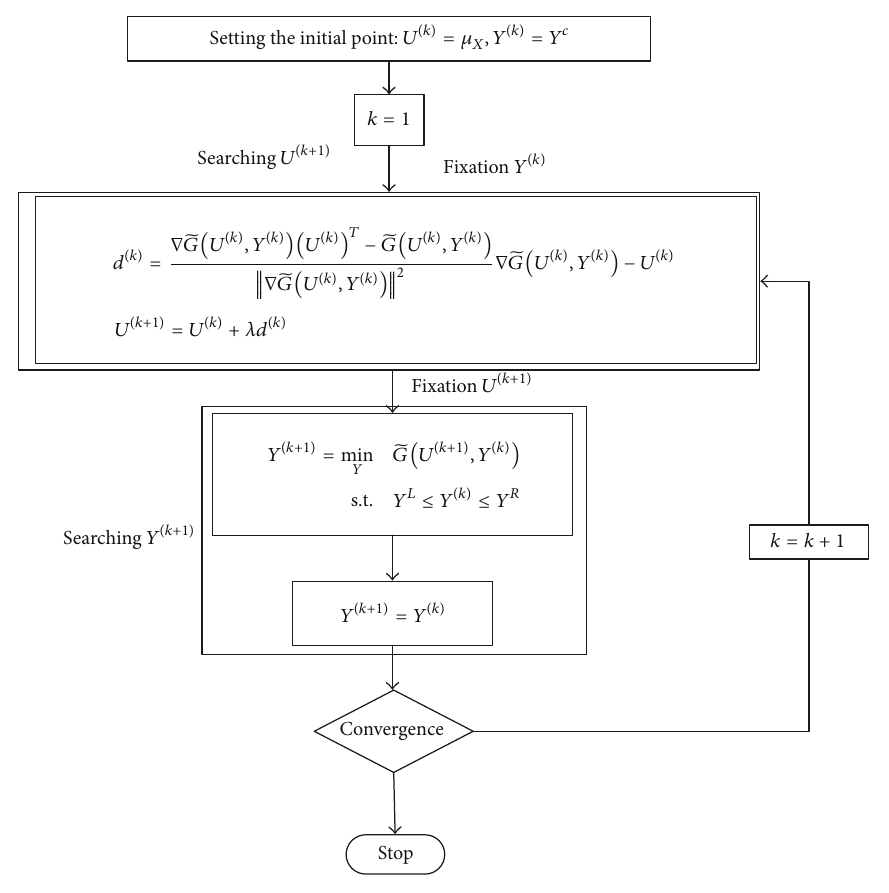
Figure 3: Flow chart of decoupling